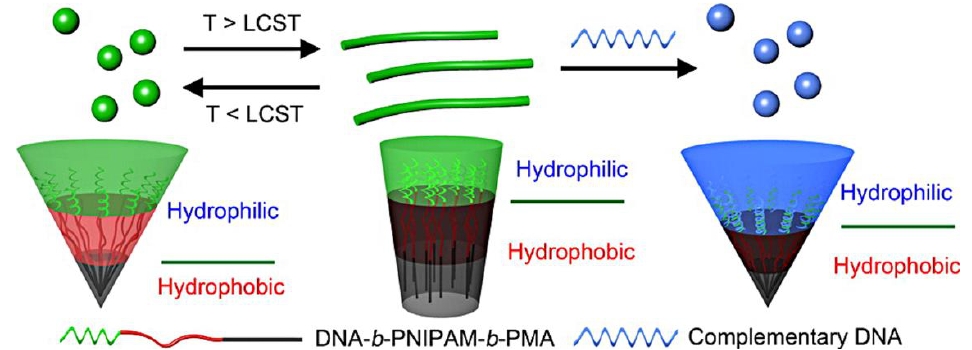
Figure 5. Self-assembly behavior of triblock copolymer of DNA- b -PNIPAM- b -PMA. Under LCST, the triblocks assembled into spherical micelles; above LCST, the spherical micelles transferred into cylinderic micelles. Further, the cylinder turned into spherical micelles by hybridizing with extended complementary DNA sequences. The green color indicate DNA strands, the red indicates polymer PNIPAM and the blue color stands for complementary DNA. Reproduced with permission from the authors of a previous paper [66]. Copyright 2016 American Chemical Society.